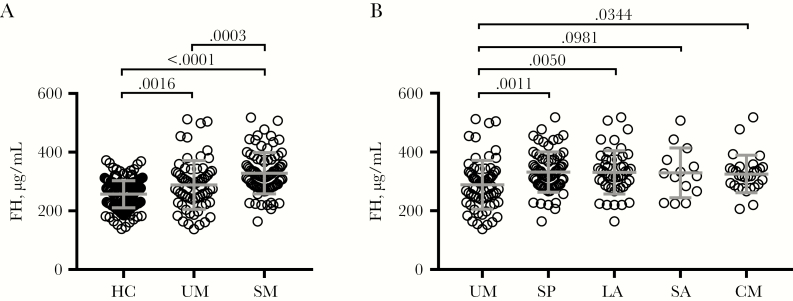
Factor H (FH) plasma levels associate with malaria susceptibility and severity. A, FH was measured by in-house enzyme-linked immunosorbent assay in samples from healthy community control children (HC; n = 173) and in samples obtained 28 days after hospital presentation from children with uncomplicated malaria (UM; n = 67) and severe malaria (SM; n = 82). P values indicate Tukey’s multiple comparisons test performed after 1-way analysis of variance. B, Severe malaria was categorized based on major criteria of severity: severe prostration (SP; n = 69), hyperlactatemia (LA; n = 48), severe anemia (SA; n = 14), and cerebral malaria (CM; n = 29). Due to overlapping clinical features, depicted groups are not mutually exclusive. Unpaired t tests compare the mean of each group with uncomplicated malaria. Bars indicate mean ± SD.